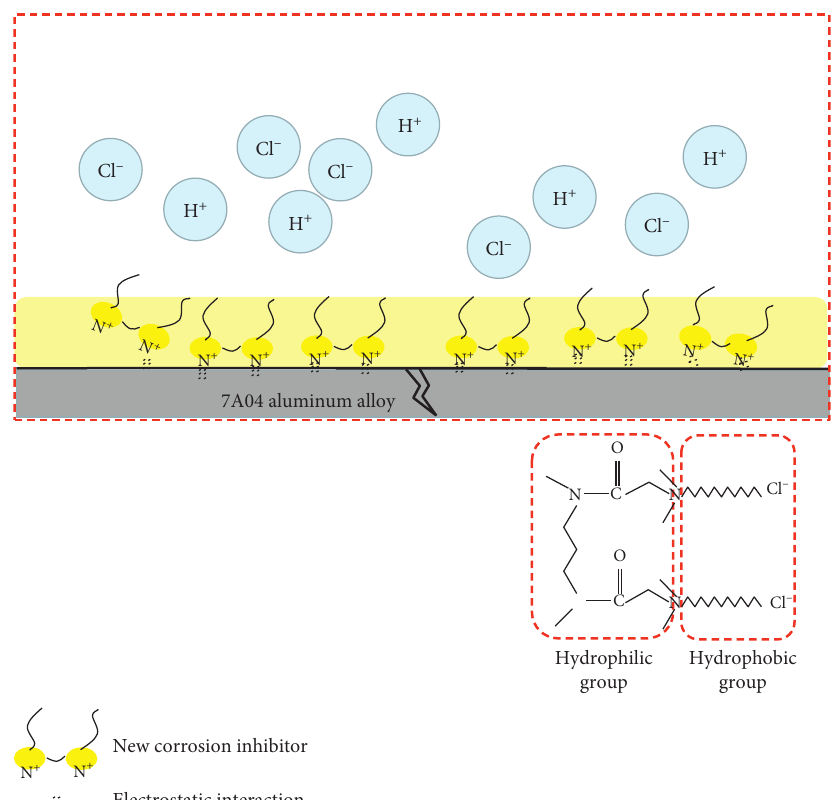
Figure 17: Schematic diagram of the corrosion inhibition mechanism of the new corrosion